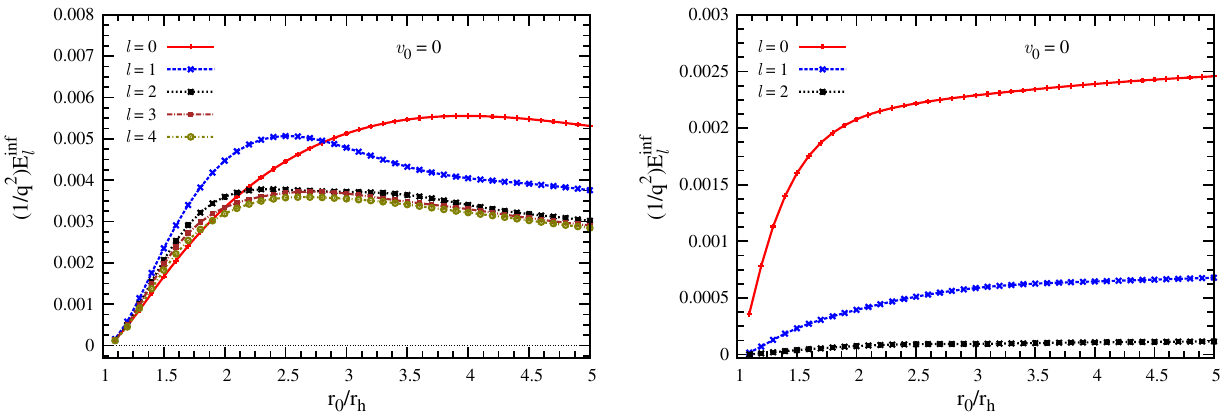
Fig. 6 Numerical estimates of the emitted energy radiated to infinity, E inf on the left) and Eq. (35) with B = 0 (plots on the right) for selected choices of multipole numbers obtained from Eq.